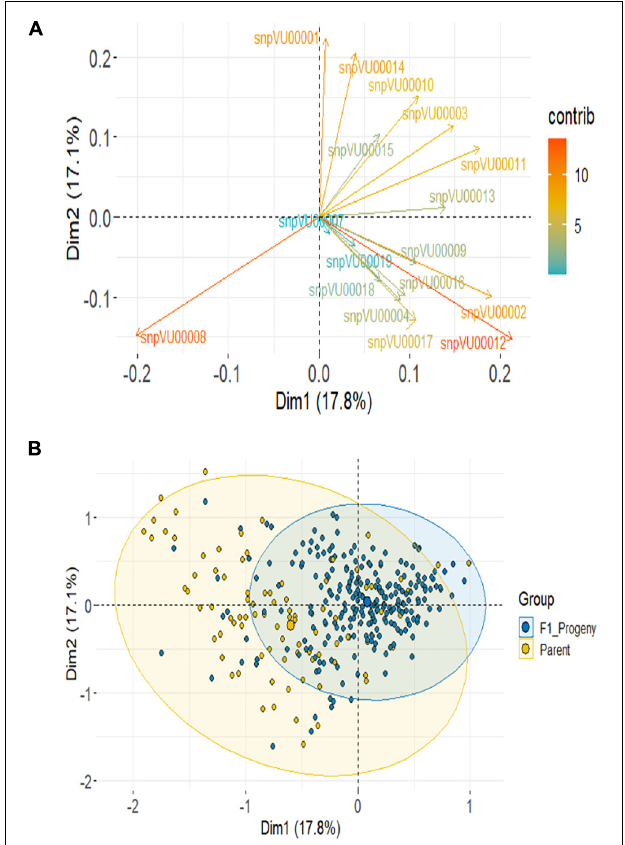
FIGURE 7 | Distribution of heterozygosity between the F 1 and their parents. (A) Bar chart displaying the proportion of heterozygous loci on the y -axis and the genotypes on the x -axis. (B) Box plot depicting the dispersion of heterozygosity between the F 1 and the parents. Inserts in panel (B) depicts summary statistics; minimum, maximum, and mean heterozygosity among F 1 and the parents, respectively. The symbol ∗ represents genotypes (both parents and F1s) with high proportion of heterozygous